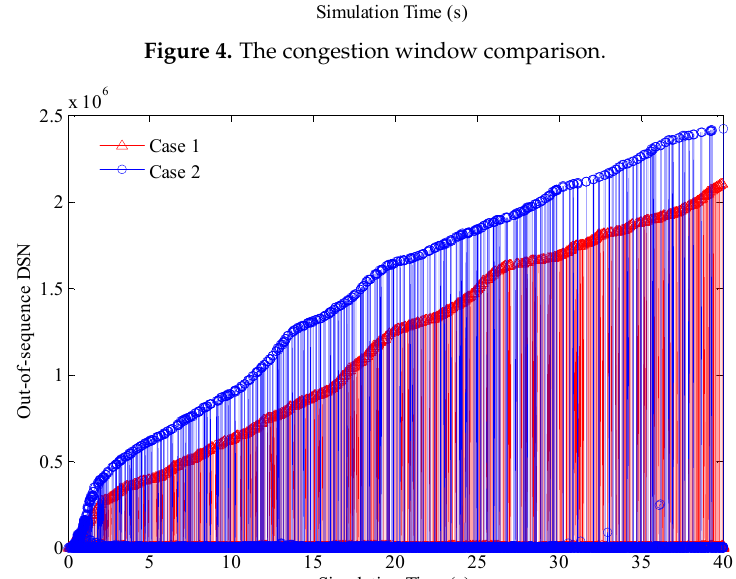
Figure 5. The out-of-order data